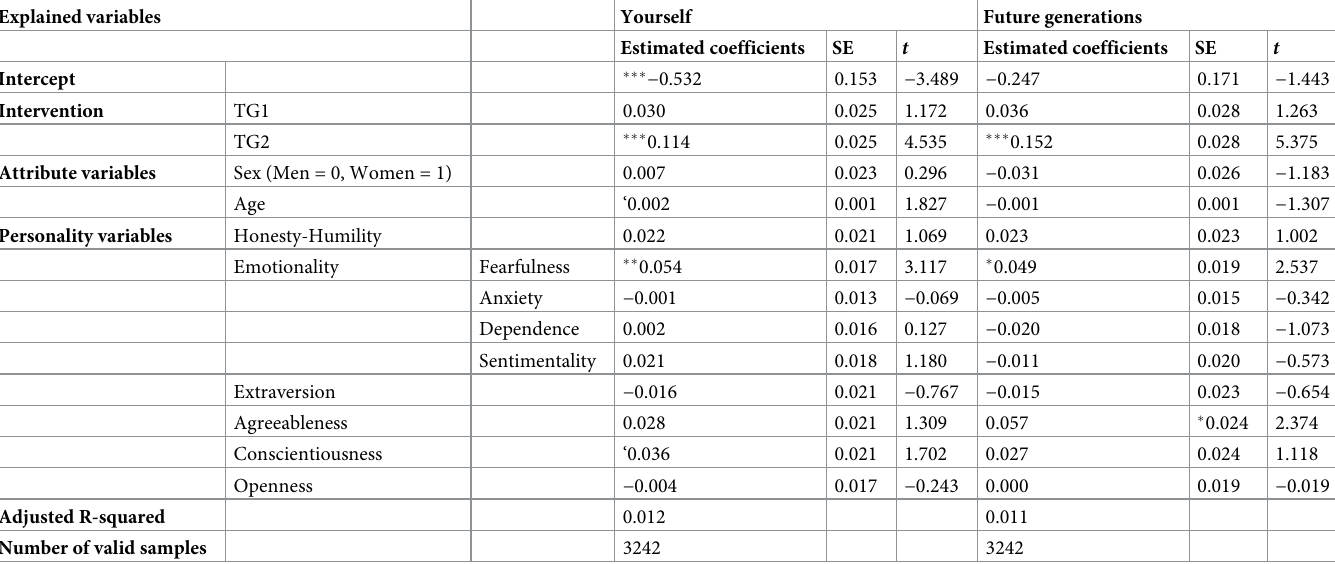
Table 8. Coefficients from linear regression